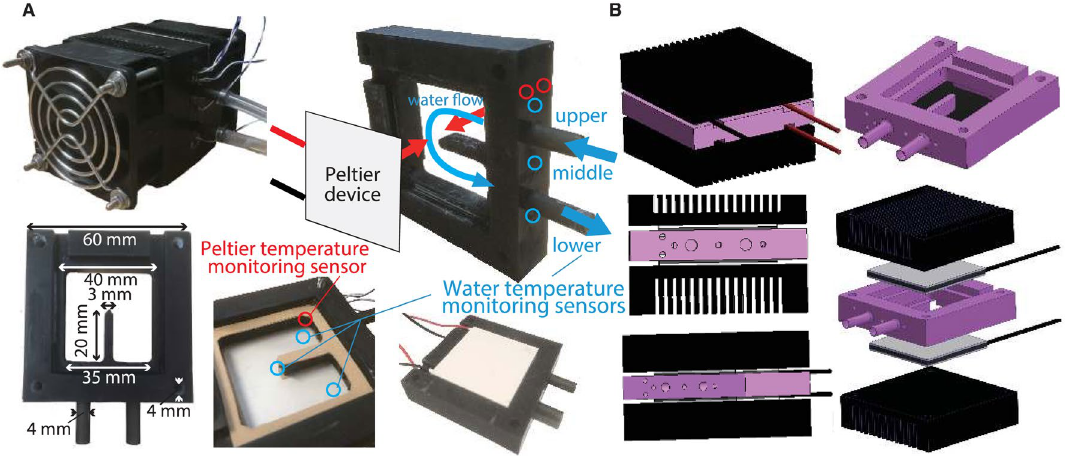
Figure 3. Design of the water tank. ( A ) The customized tank comprises two heat sinks integrated with fans, 3D printed tank, and two Peltier devices. The tank has double-faced heat (and cold) sources; the top and bottom faces are made of the Peltier devices themselves so that water can be heated and cooled directly. The gaskets are put between the tank and heat sink to avoid water leakage. There are five holes to attach thermocouples; two are for measuring Peltier devices’ temperature, three are for water (upper side, middle, and lower side). The extrusion inside the tank covers the middle sensor for measuring water temperature to avoid contact with the Peltier devices. ( B ) The water storage part (pink part of this figure) is built by a 3D printer, designed to embed the Peltier devices and sandwich them using heat sinks from above and below. The part is made of a resin monomer, of which heat conductivity is low that can avoid heat loss from the tank